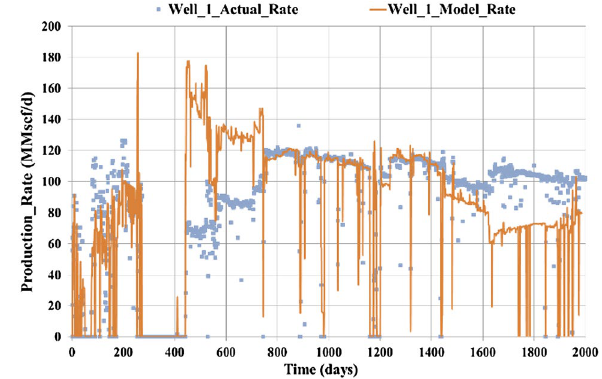
Fig. 15 Well 1 production history match (case 2)